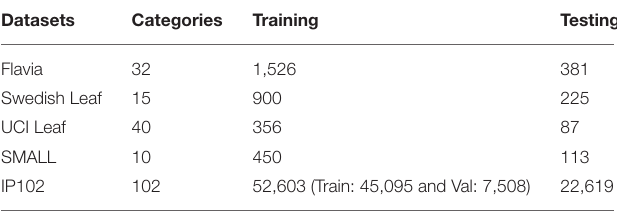
TABLE 5 | Ablation study of different samplers used in CRM on RPDID.